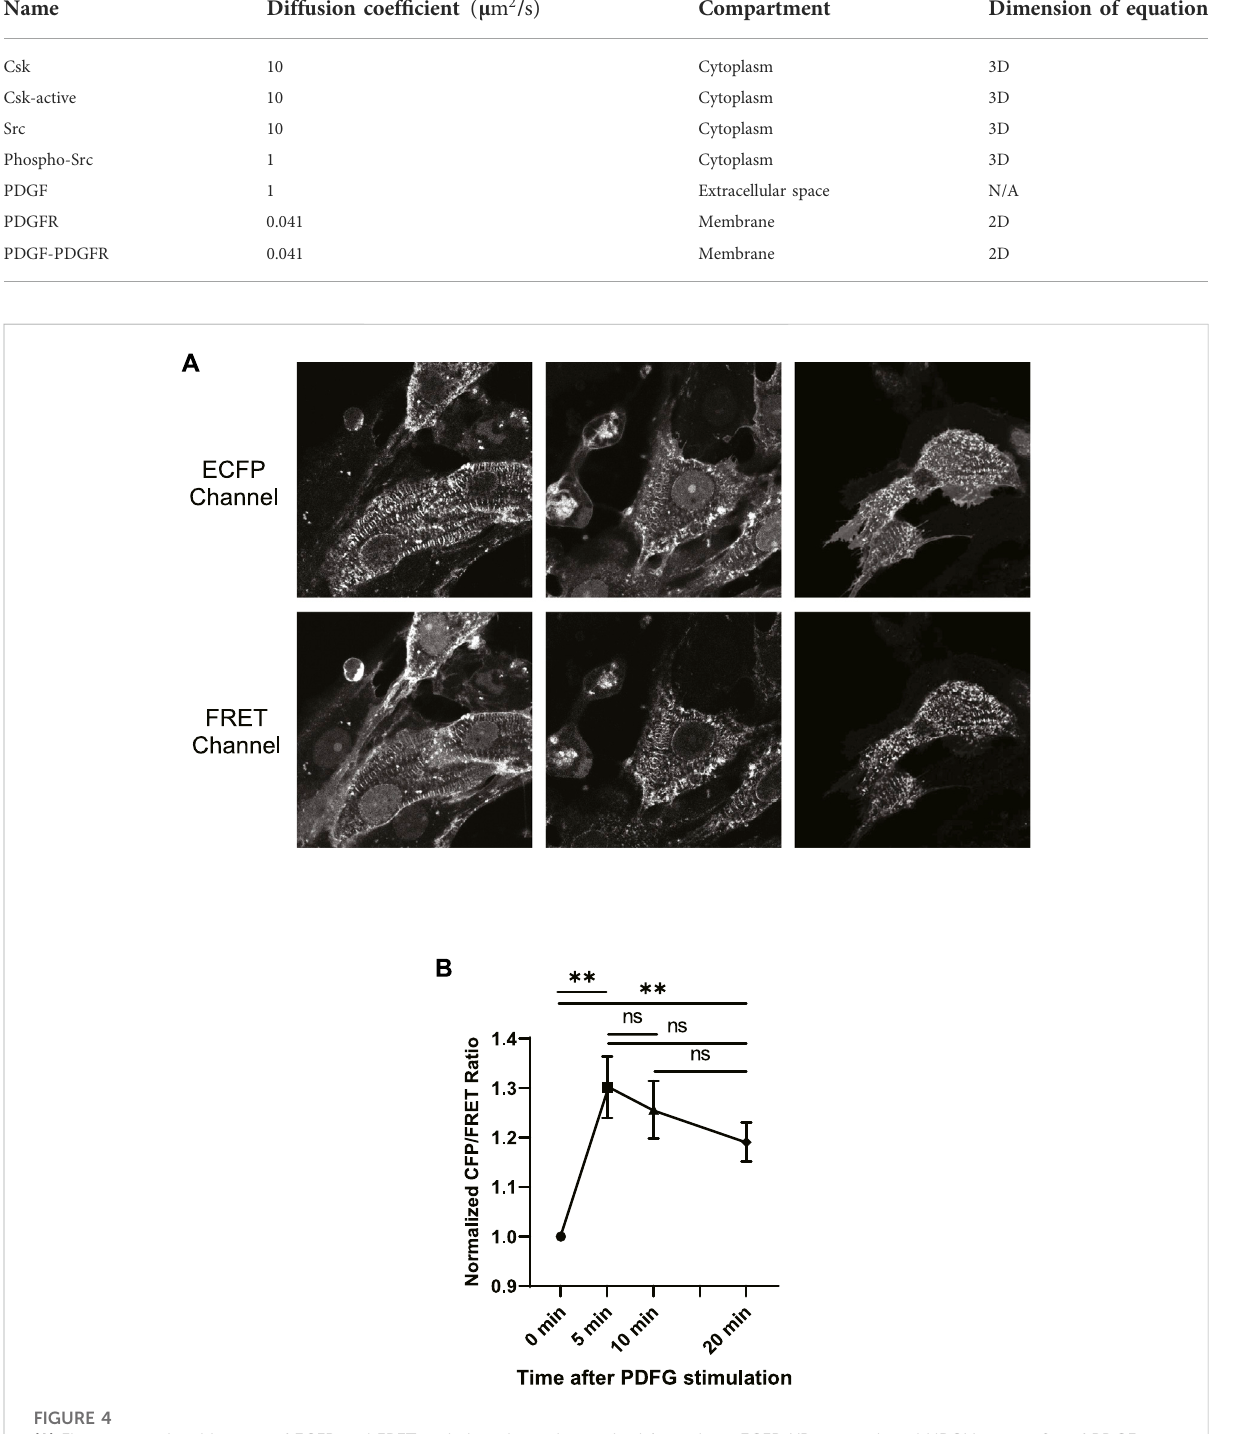
TABLE 3 Diffusion coef fi cient, compartment and dimension of equation that applied to the molecules, interacting in the PDGF signaling (Rangamani et al., 2013).